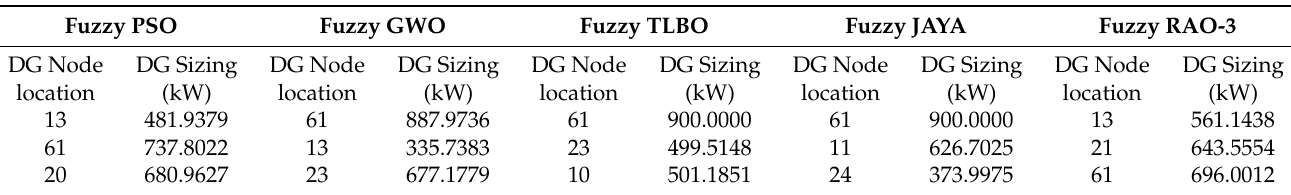
Table 2. DG optimum location and sizing.